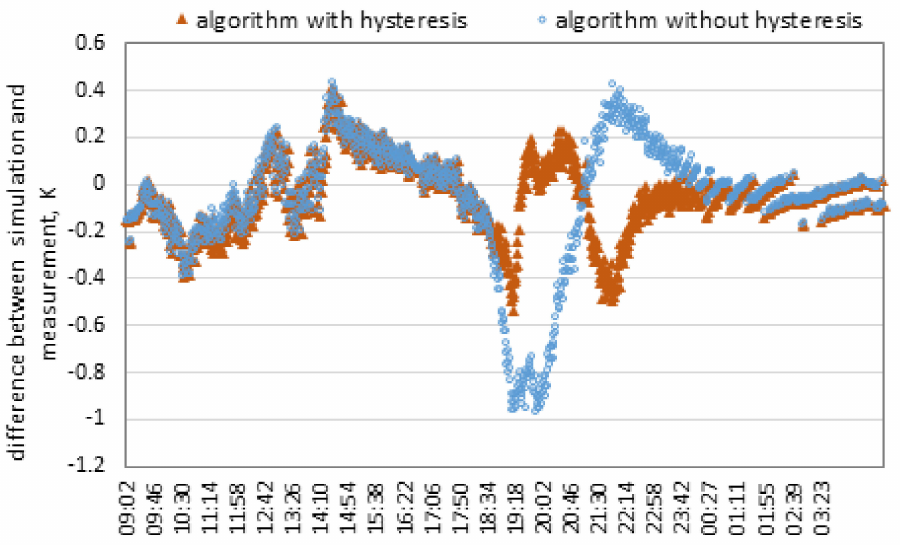
Figure 7. Absolute momentary errors of simulation.